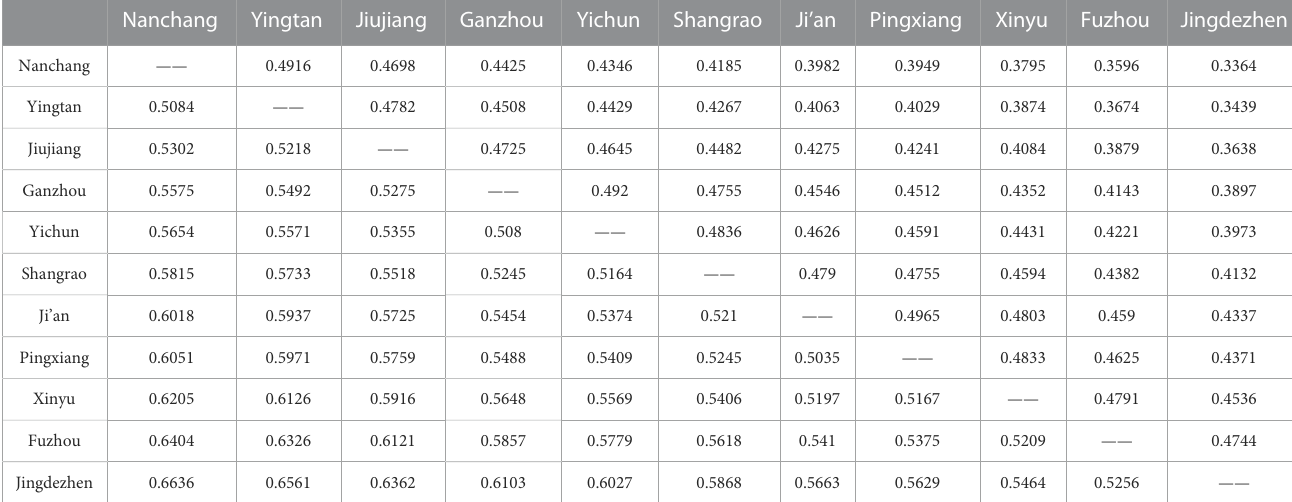
TABLE 5 Attractiveness